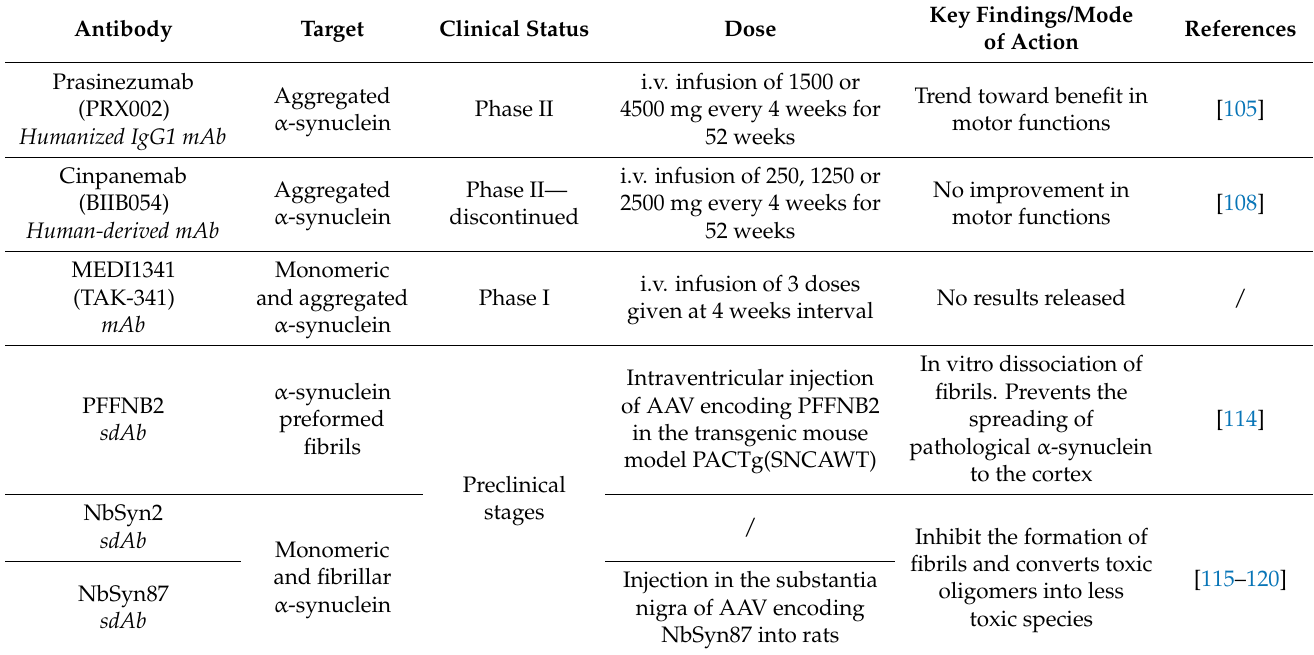
Table 5. Monoclonal antibodies tested for Parkinson’s